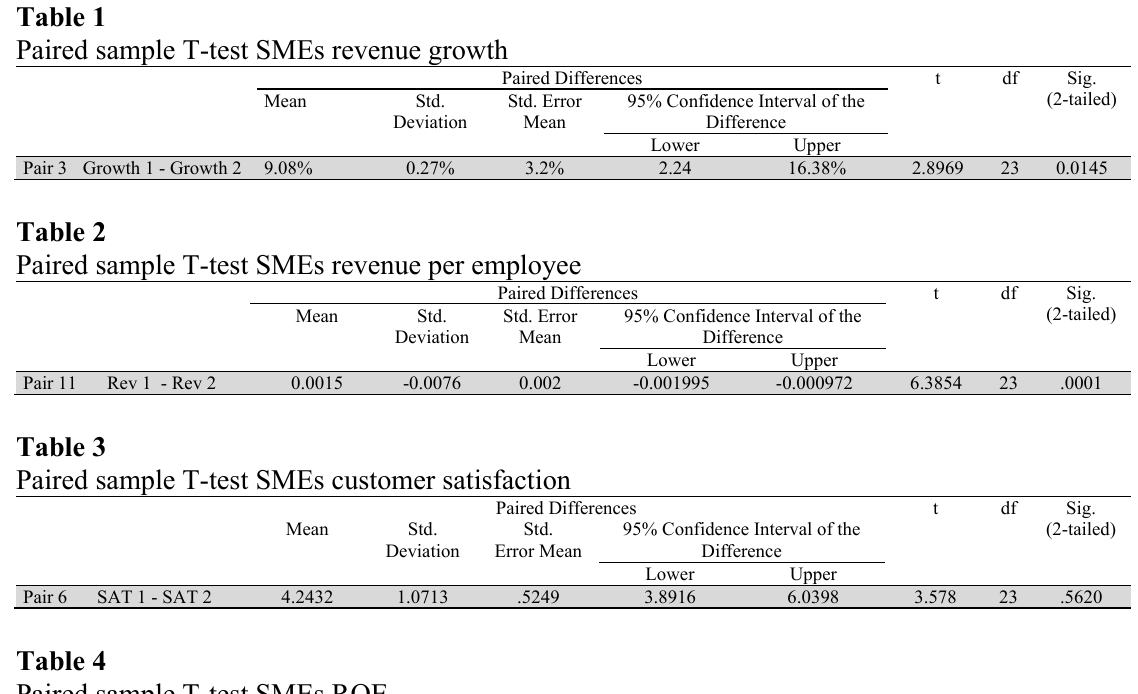
Paired Differences